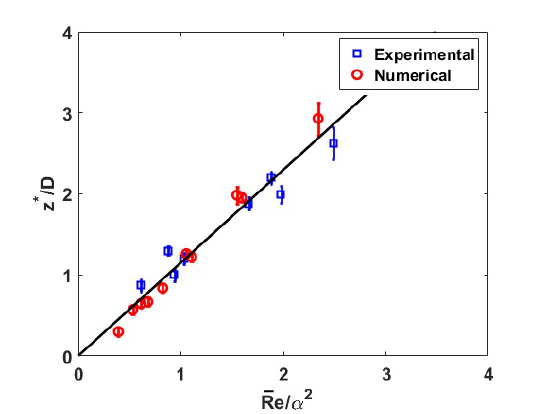
Figure 11: Dimensionless maximum vortex displace- ment, z ∗ /D , as a function of the dimensionless param- eter ¯ Re/α 2 for experimental data (blue squares) and numerical data (red